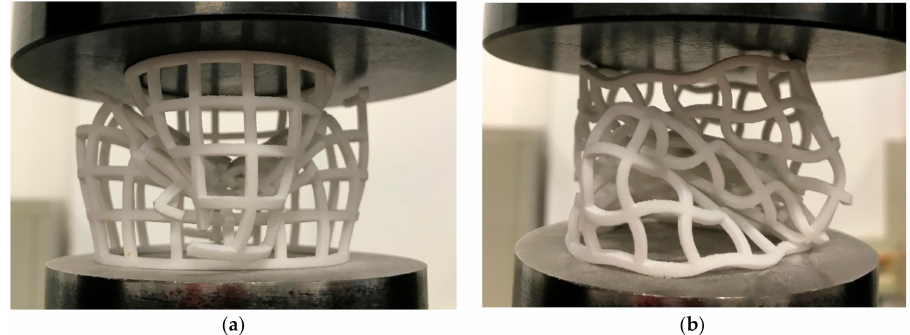
Figure 12. ( a ) CCHT0 at the displacement of 65 mm under quasi-static test. ( b ) CCHT1 at the displacement of 65 mm under quasi-static test.